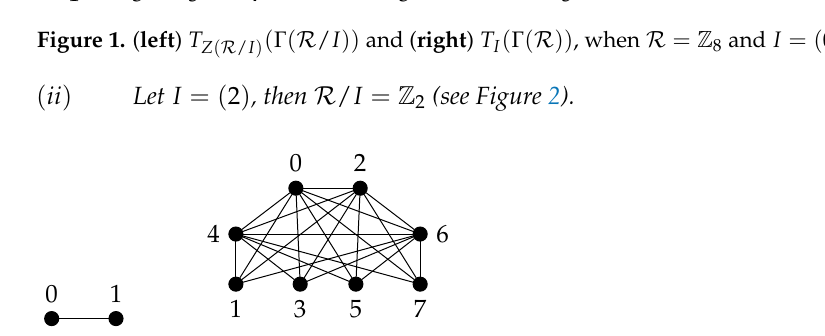
Figure 2. ( left ) T Z ( R / I ) ( Γ ( R / I )) and ( right ) T I ( Γ ( R )) , when R = Z 8 and I = ( 2 ) . ( iii )